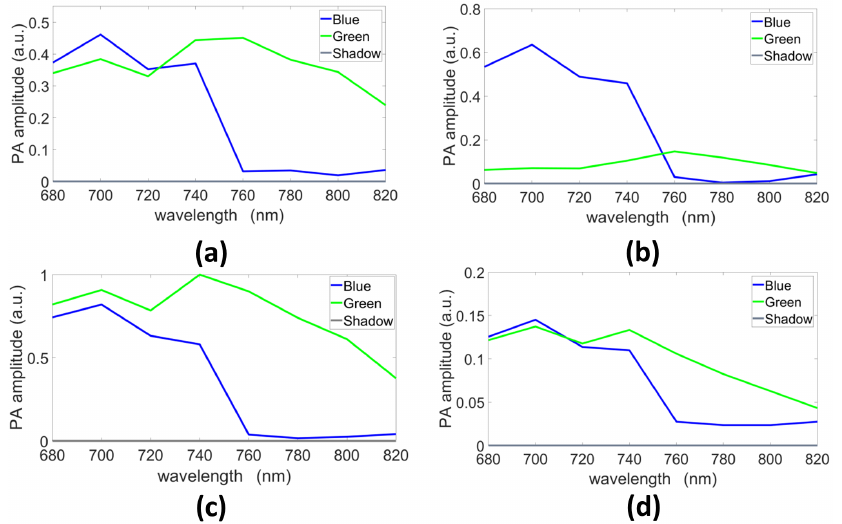
Figure 9. Endmembers extracted with ( a ) GLUP, ( b ) VCA, ( c ) N-FINDR, and ( d ) SSM-S (a.u., arbi- trary units).